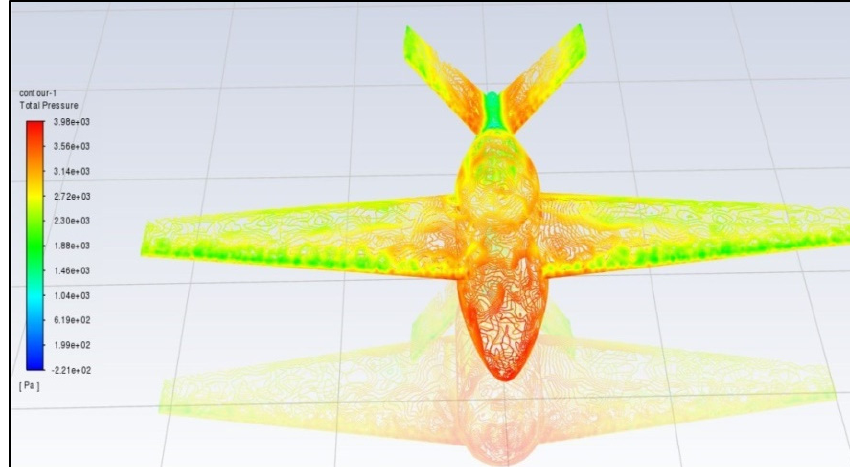
Figure 27. Total pressure